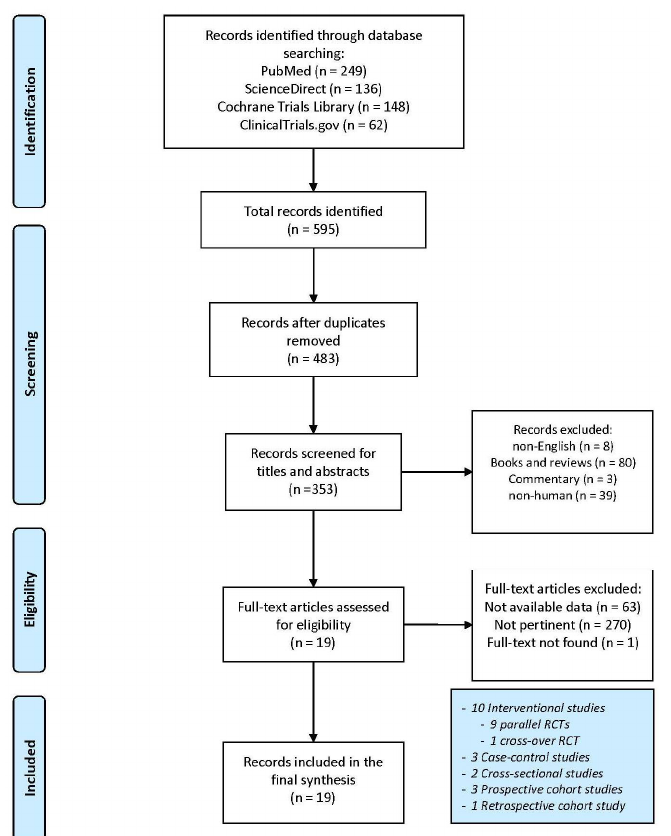
Figure 1. Flow chart for study selection. Adapted from Moher et al. [37].